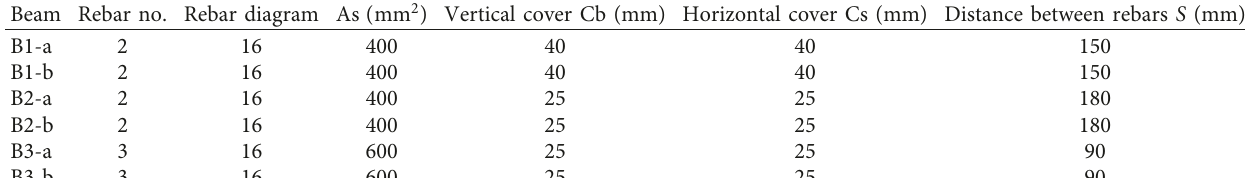
Table 1: Geometry and properties of RC shallow beams [38].